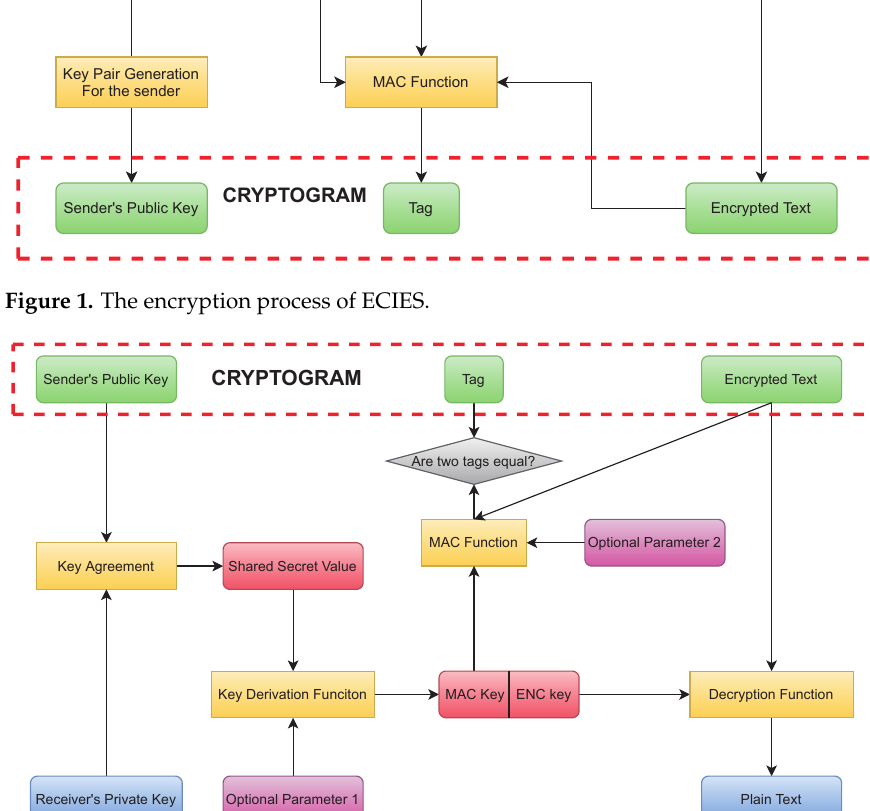
Figure 2. The decryption process of